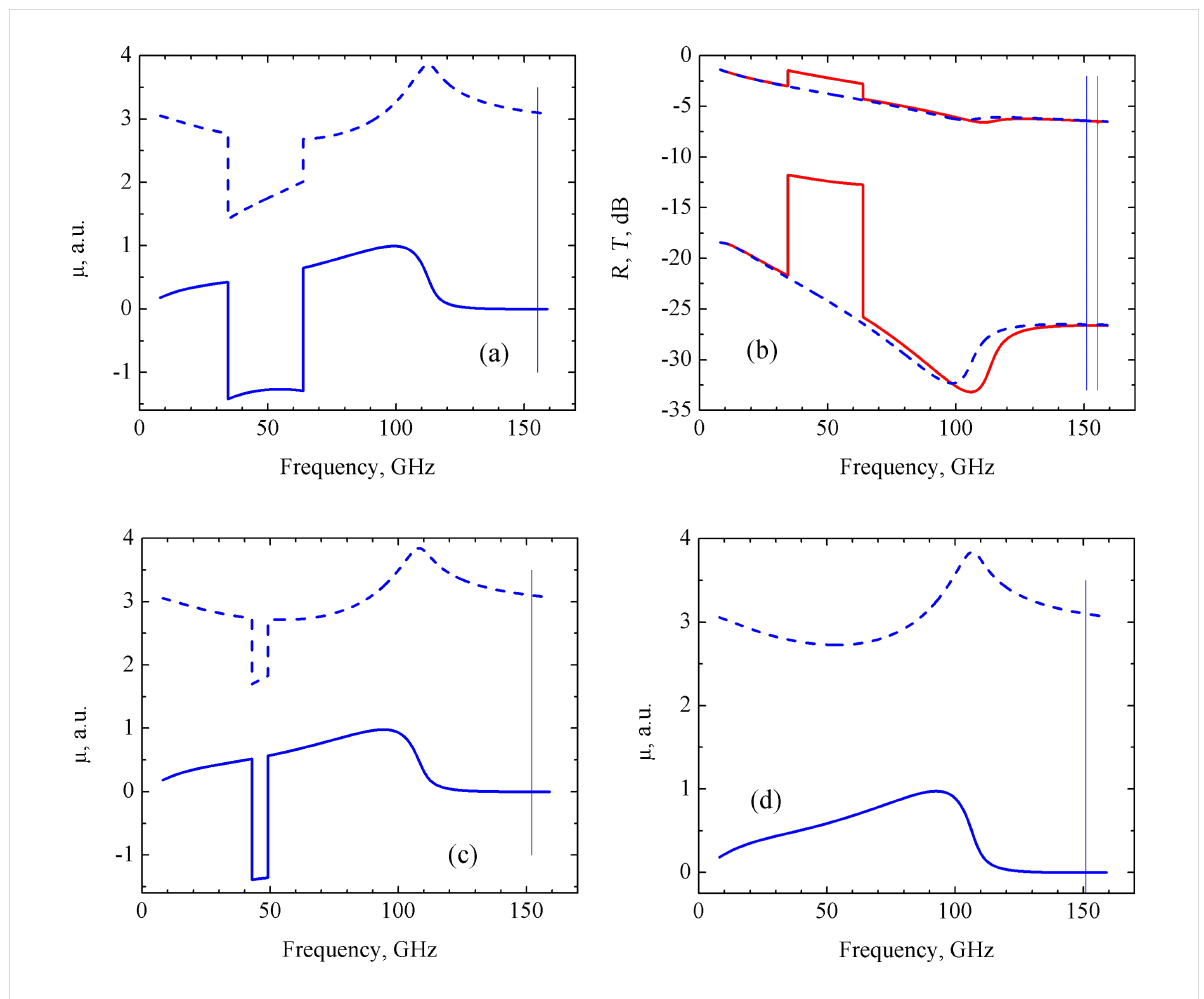
Figure 3: Frequency dependence of the real (dashed lines) and imaginary (solid lines) parts of the permeability (a,c,d), and of the reflection R (upper curves) and transmission T (lower curves) coefficients (b) of the CNT-based nanocomposite consisting of a series–parallel circuit. (a) R i = 0.007 Ω , L i = 0.07 pH, C i = 15 pF ( ω 0 = 155.3 GHz); (b) R i = 0.007 Ω , L i = 0.07 pH, C i = 15 pF ( ω 0 = 155.3 GHz) (red solid lines) and R i = 0.007 Ω , L i = 0.075 pH, C i = 15 pF ( ω 0 = 151.1 GHz) (blue dashed lines); (c) R i = 0.007 Ω , L i = 0.073 pH, C i = 15 pF ( ω 0 = 152.1 GHz); (d) R i = 0.007 Ω , L i = 0.075 pH, C i = 15 pF ( ω 0 = 151.1 GHz). The resonance frequency of the R i L i C i circuits, ω 0 , are indicated by vertical